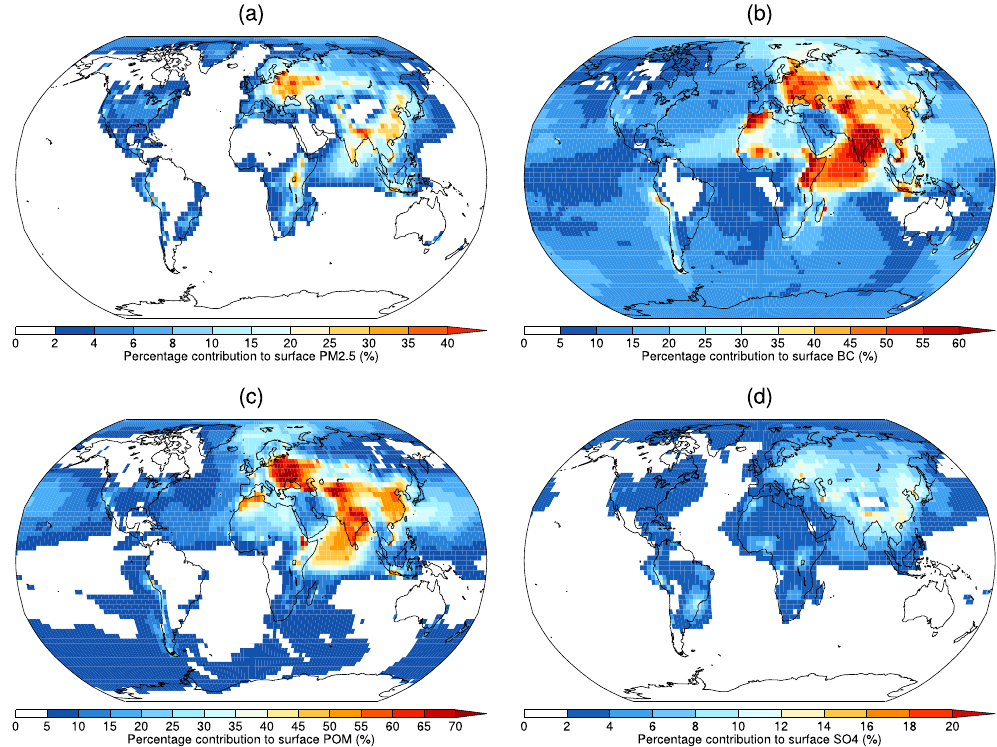
Figure 7. Percentage contribution of residential emissions to annual surface mean PM 2 . 5 (a) , BC (b) , POM (c) , and sulfate (SO 4 ) (d) concentrations (in size fraction PM 2 . 5 ) for the baseline simulation (res_base), relative to an equivalent simulation where residential emissions have been removed